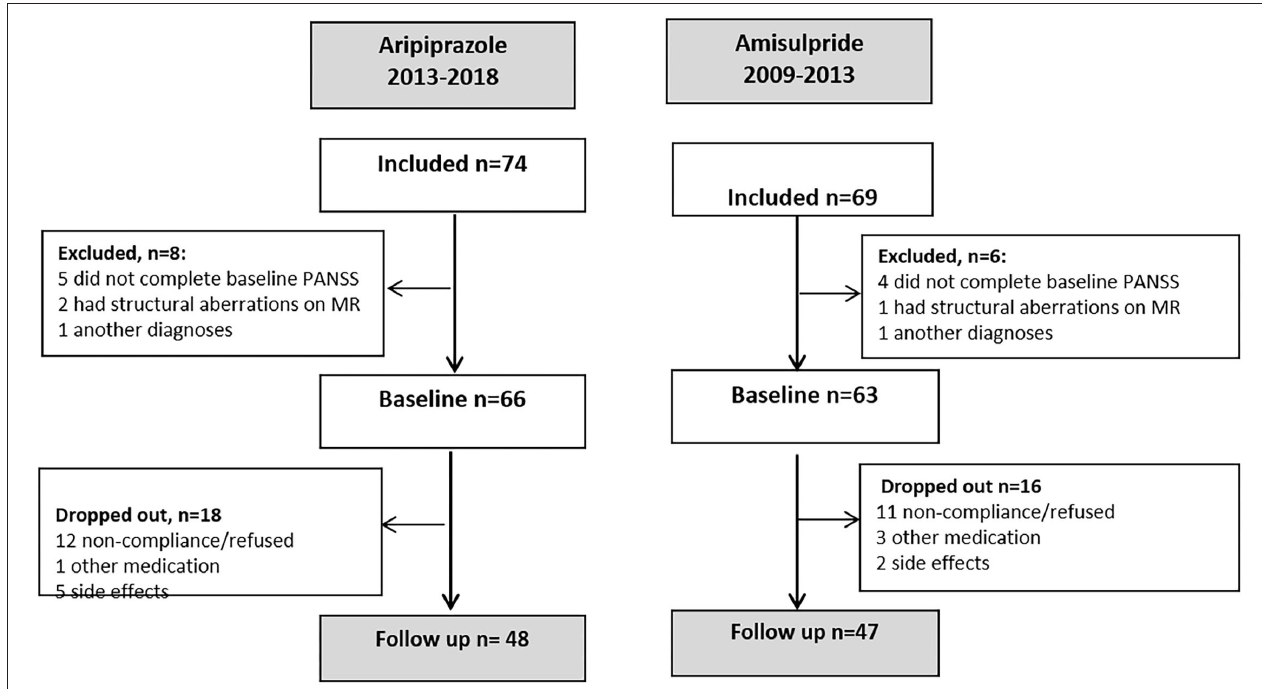
FIGURE 1 | Flowcharts of the two studies.